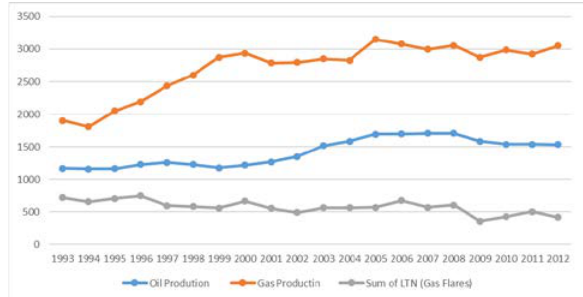
Figure 11. Development of Oil and Natural Gas Production with NTL in Algeria between 1993-2012.